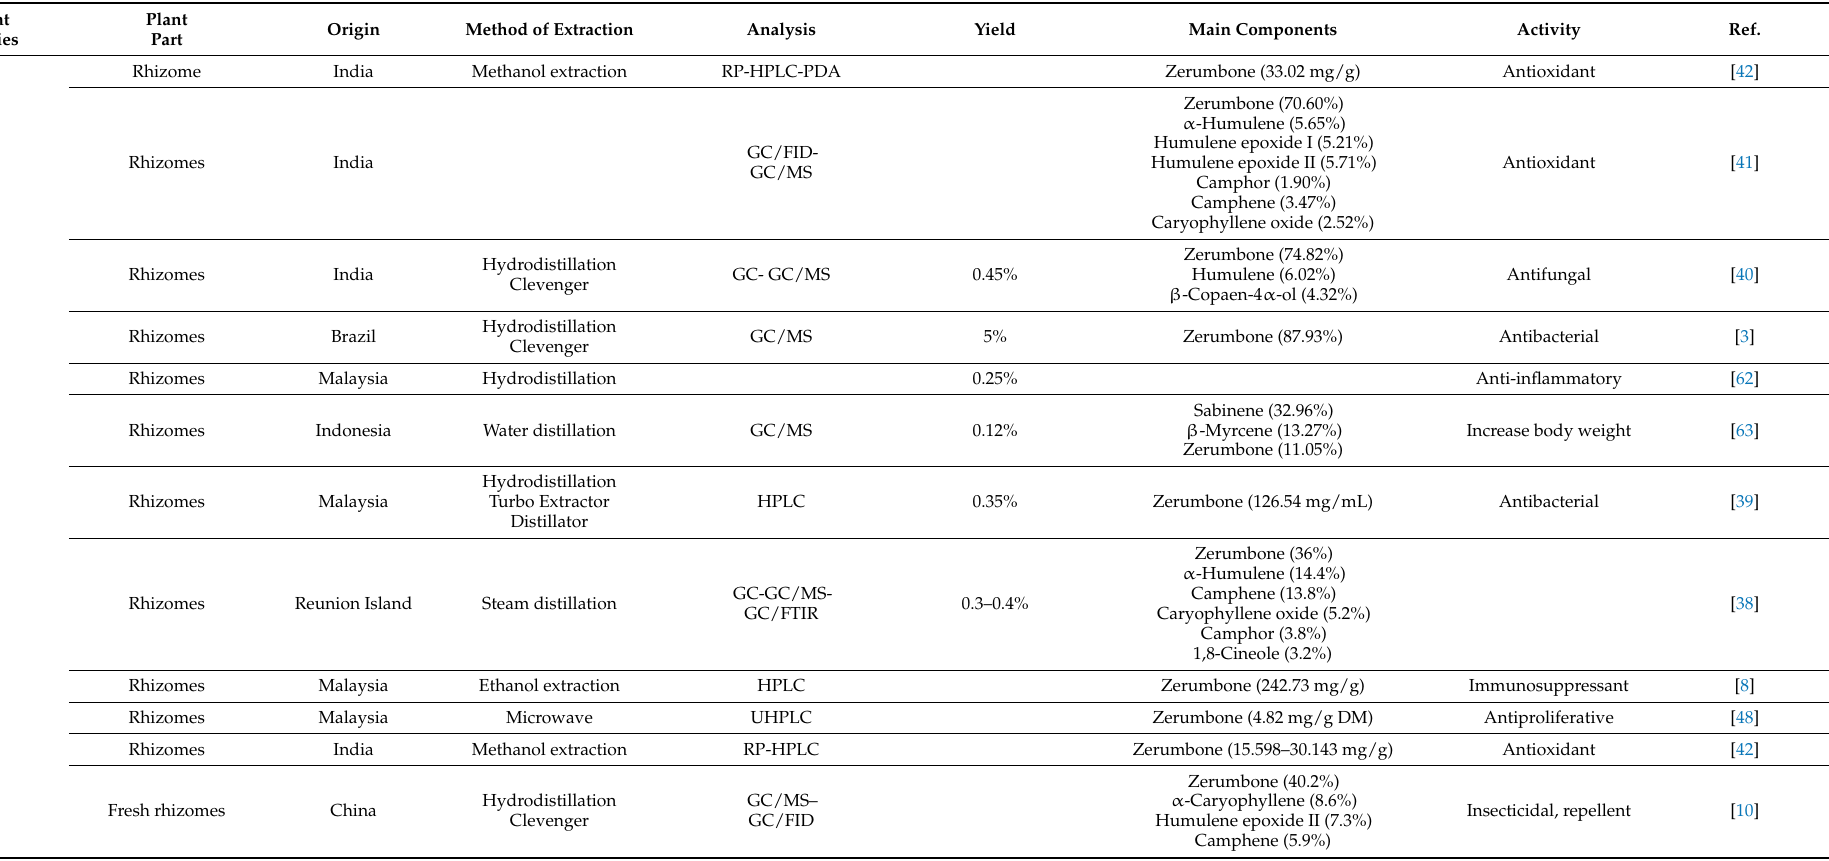
Table 1. Natural sources of zerumbone according to the plant species, origin, method of extraction and analysis. RP-HPLC-PDA: reverse phase high performance liquid chromatography, GC-MS: gas chromatography-mass spectrometry, FID: flame-ionization detector, HPLC: high performance liquid chromatography, FTIR: Fourier transform infrared spectroscopy, UHPLC: ultra-high performance liquid chromatography, HRESI: high-resolution electrospray ionization mass, EI-MS: electron ionized-mass spectroscopy, 1 H-NMR: (nuclear magnetic resonance) and 13